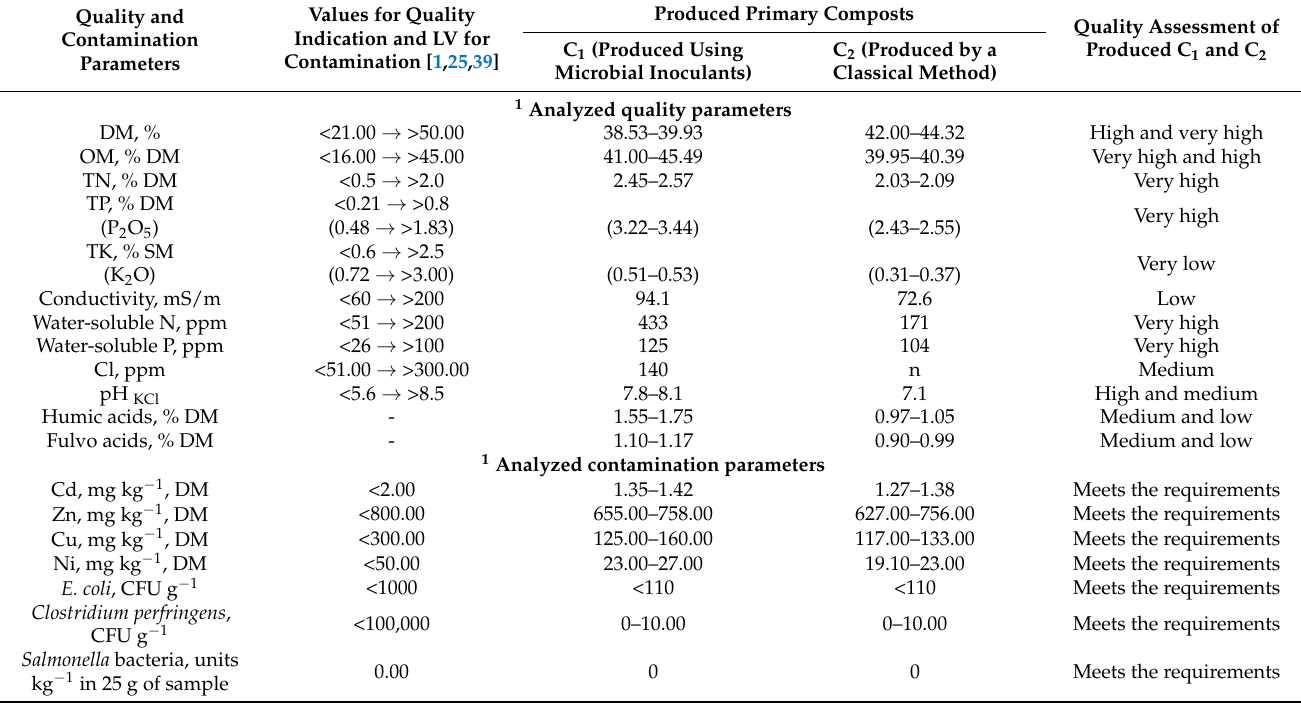
Table 4. Results of laboratory analysis of the produced primary